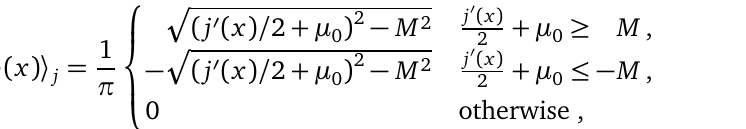
( x ) with βϕ = 0 and π when j 0